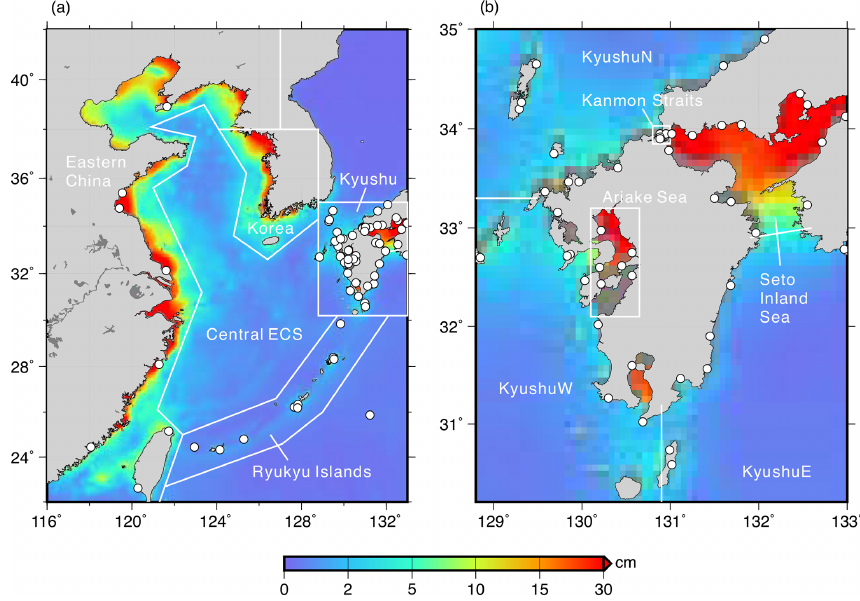
Figure 2. The M 2 standard deviations for nine ocean tide models (DTU10, EOT11a, FES2014b, GOT4.10c, HAMTIDE11a, NAO99Jb, NAO99b, OSU12, and TPXO9-Atlas). Panel (a) shows the whole East China Sea (ECS) region, while (b) is an enlargement of the Kyushu subarea of (a) . The white labelled polygons define the subareas for which the quality of the ocean tide models has been evaluated, and the white dots represent the locations of coastal tide